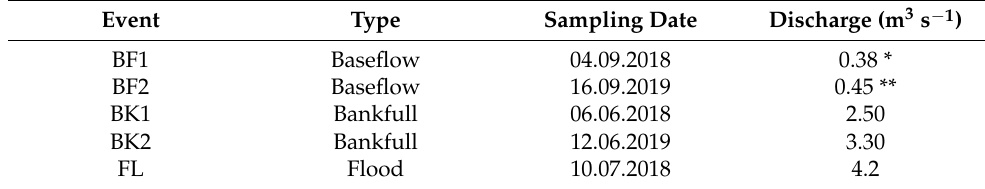
Table 1. Description of the hydrological events. BK = bankfull, BF = baseflow, FL = flood. Refer to table 3 for the full description of the sampling events.